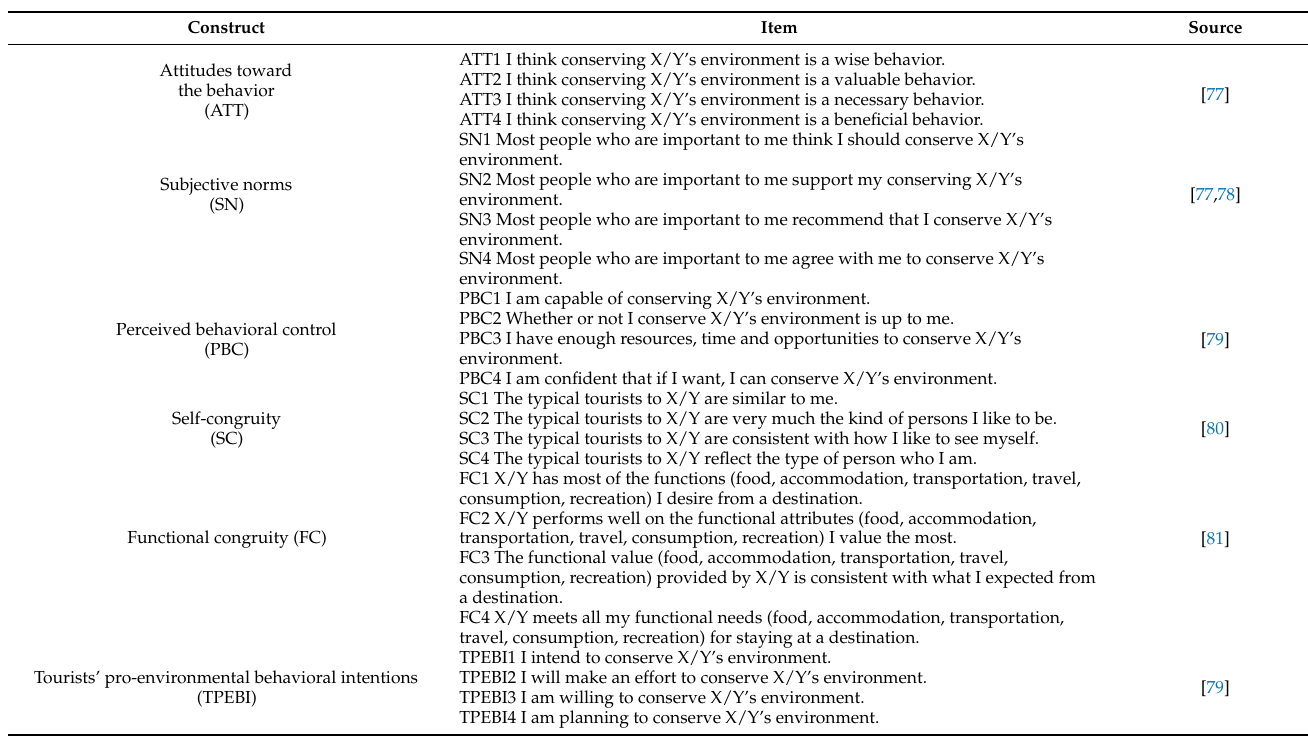
Table A1. Detailed measurements of all